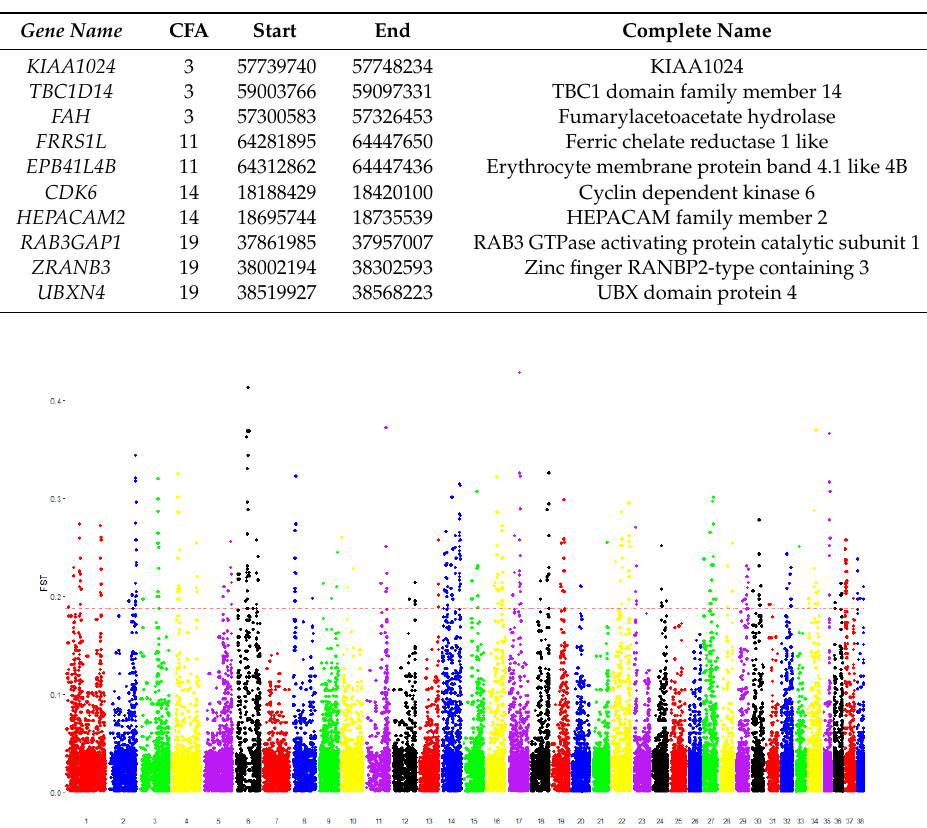
Figure 2. Manhattan plots of the cross-population extended haplotype homozygosity (XP-EHH) analysis comparing cases vs. controls. Manhattan plot of log 10 XP-EHH values. Each SNP is represented by a dot. Each chromosome is represented by a different color. The dotted red line represents the cutoff value of the top 1%, equal to 2.73. The genomic regions in which SNPs were mapped over the dotted red line were considered as significantly different between the two compared groups.